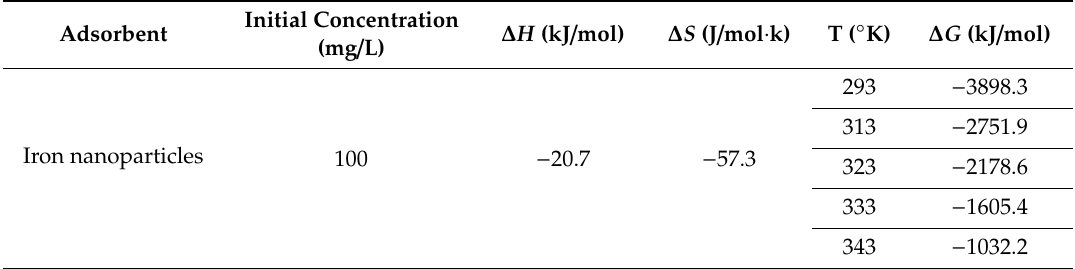
Table 7. Thermodynamic parameters of arsenic adsorption onto the synthesized iron nanoparticles.